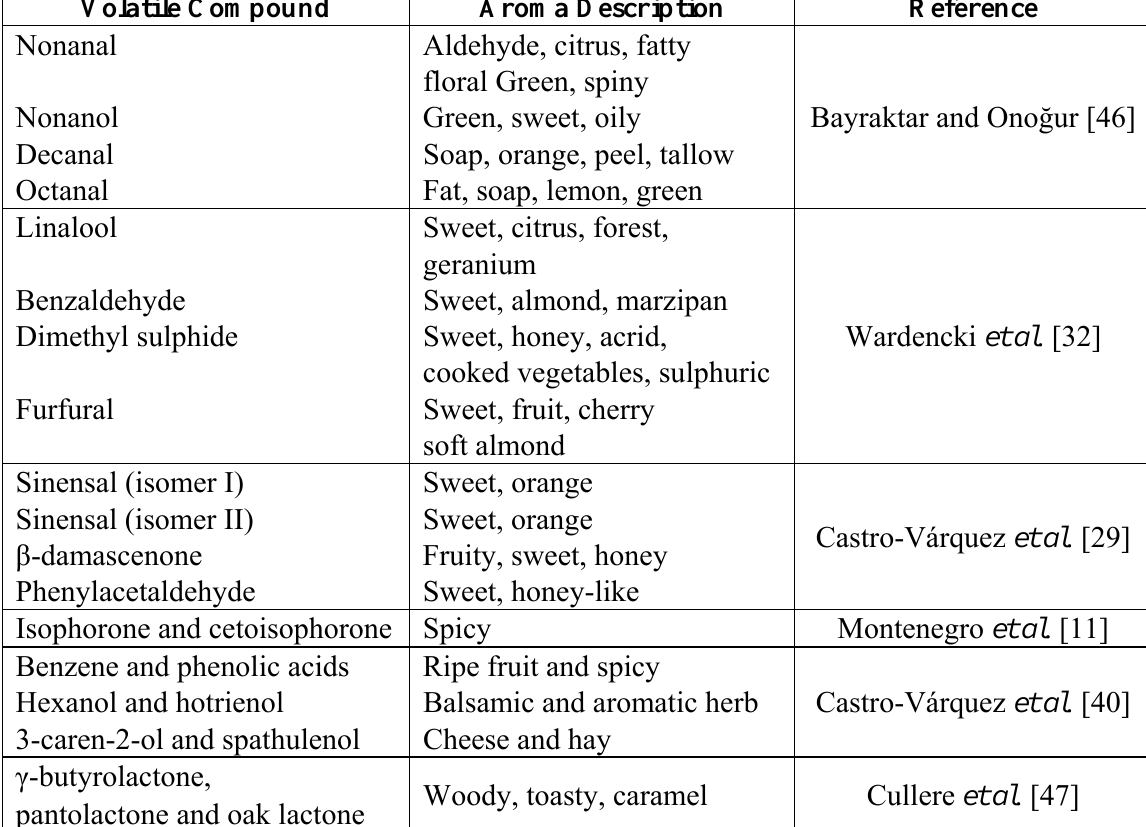
Table 2. Aroma description of some volatile organic compounds in